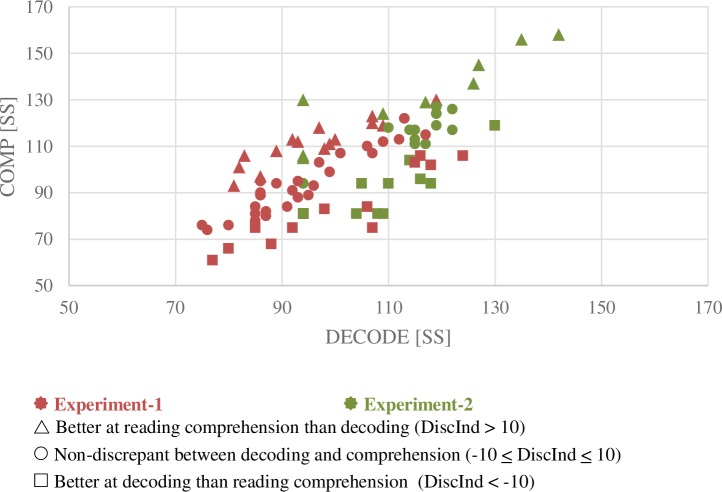
Scatter-plot of decoding (DECODE; WRMT-WA SS) and reading comprehension scores (COMP; WRMT-PC SS).Participants from Experiment-1 are displayed in red. DECODE and COMP measures showed a significant positive correlation (r = 0.67, p < 0.001). The discrepancy index (DiscInd; i.e., COMP “minus (-)” DECODE) was greater than 10 SS (Standard Score) for 27.3% of the participants (triangles) i.e., they were better at comprehending than decoding. Discrepancy was in the opposite direction and negative for 21.8% of the participants, i.e., less than -10 SS and they were better at decoding than comprehending (squares). Participants that did not belong to either group are those without a large discrepancy between DECODE and COMP (50.9% of the participants, circles). Participants from Experiment-2 at Time 2 are displayed in green. DiscInd was greater than 10 SS for 20.9% (triangles), less than -10 SS for 41.9% (squares), and non-discrepant (between -10 and 10 SS) for 37.2% of the participants (circles).